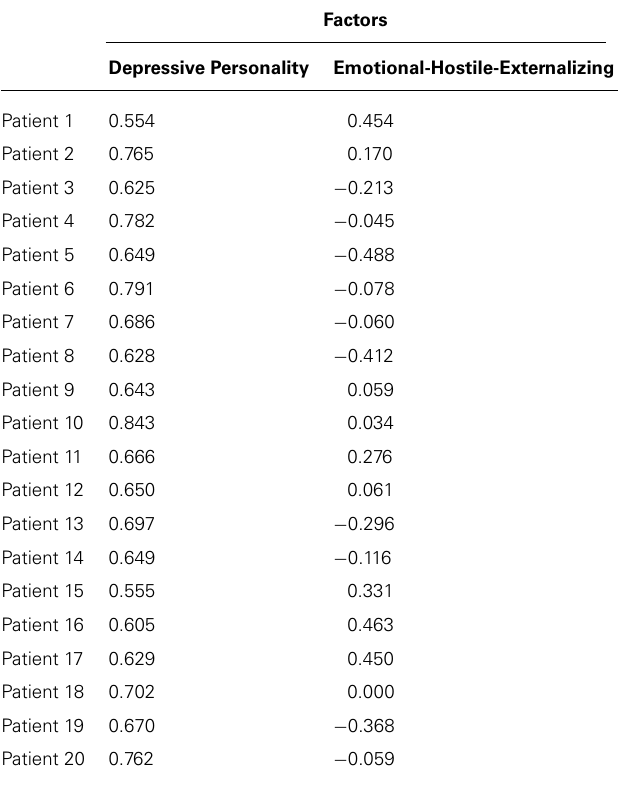
Table 3 | Factor scores of 20 patients on the factor “Depressive Personality” and “Emotional-Hostile-Externalizing Personality.” Factors